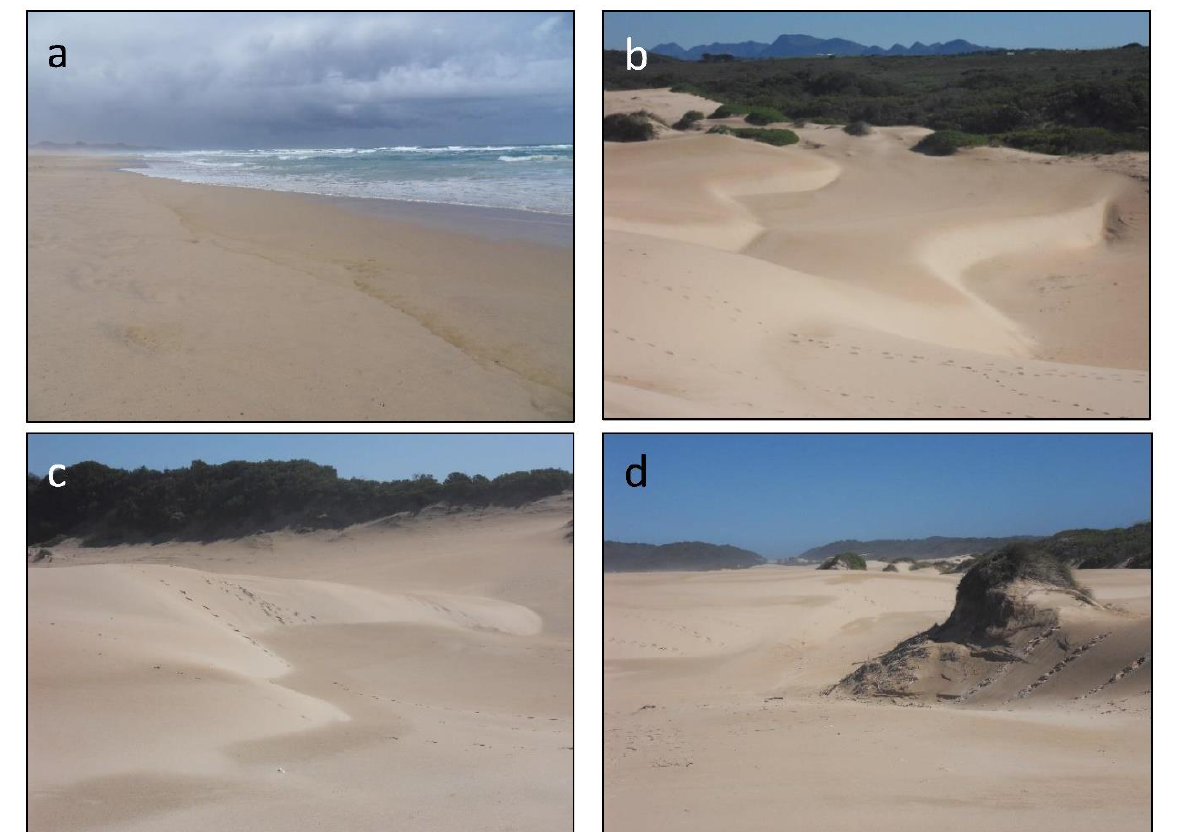
Figure 4. Dune and beach morphology at Oyster Bay. ( a ) Dissipative beachface within the lower part of the beach system; ( b , c ) migrating transverse dune ridges within the supratidal zone; ( d ) erosional hummock of an older vegetated dune system, now isolated within the upper part of the beach.